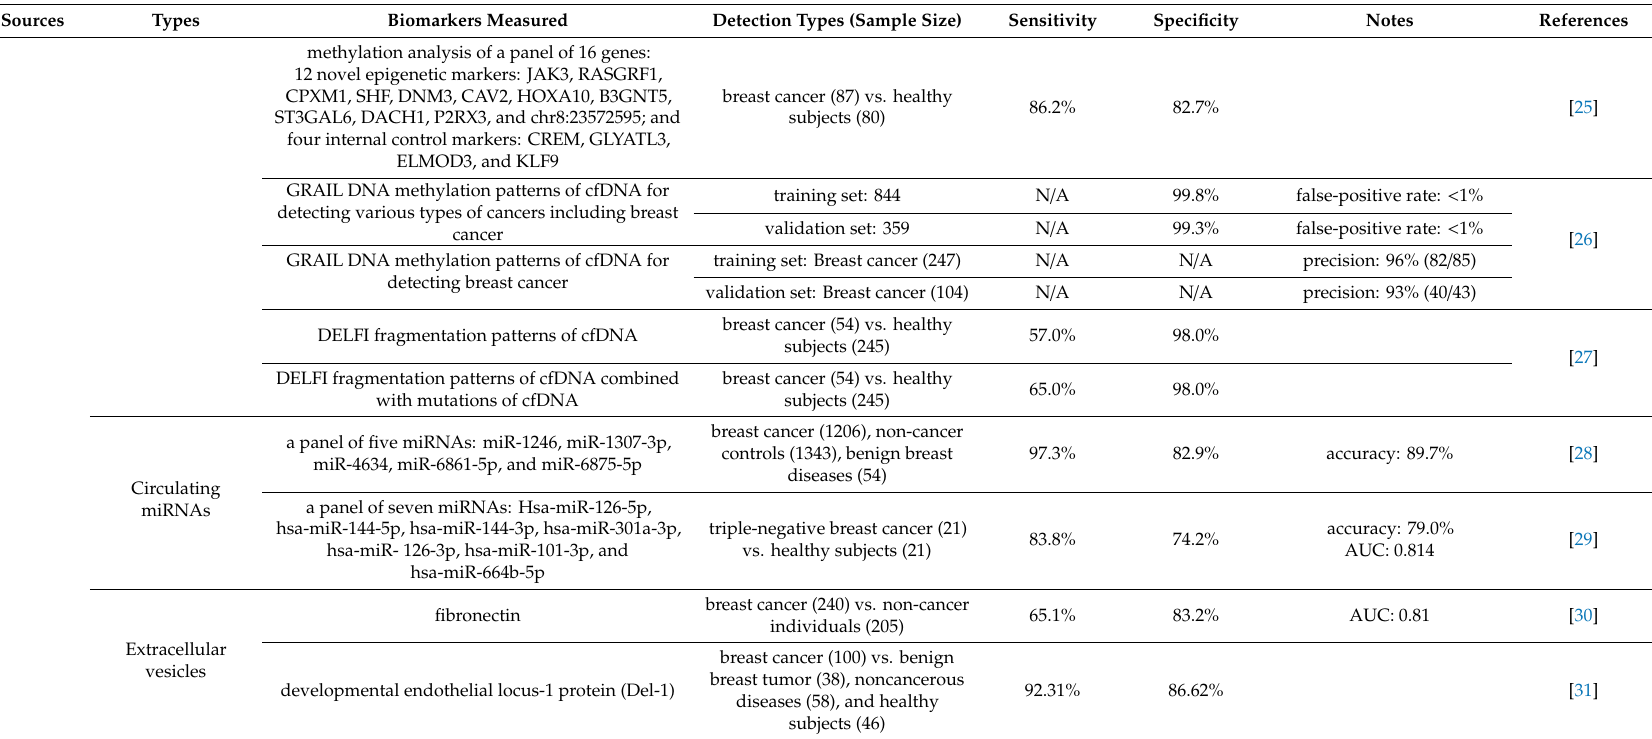
methylation analysis of a panel of 16 genes: 12 novel epigenetic markers: JAK3,